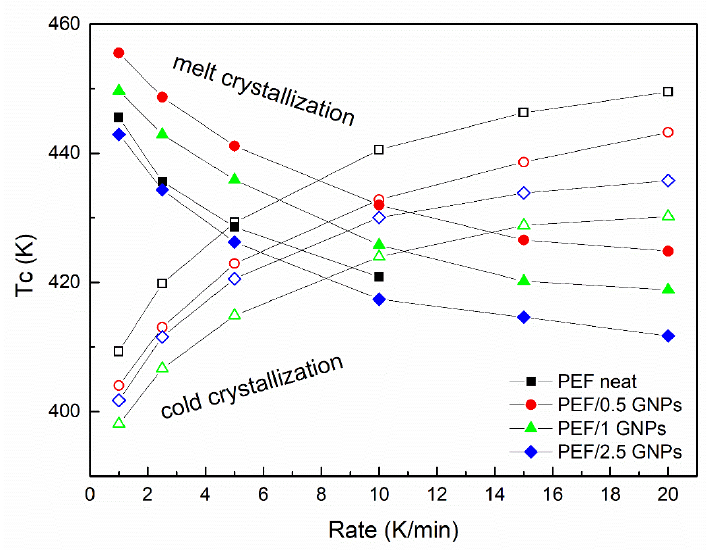
Figure 6. Cold and melt crystallization temperatures vs. heating/cooling rates of the neat PEF and PEF/GNP nanocomposites.